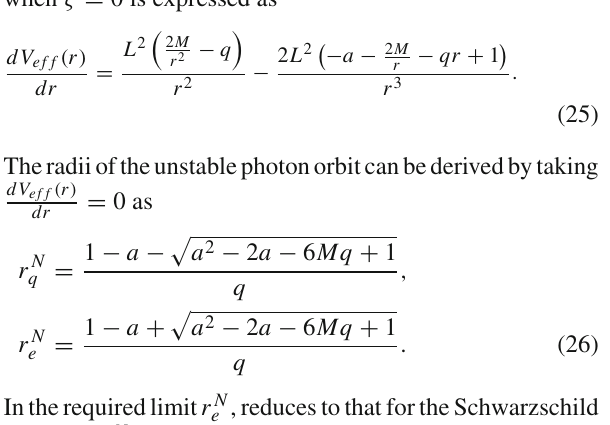
Fig. 5 Shows the behavior of V ef f ( r ) for the different possible values of a and q . The left panel of the first row represents q = 0 . 01 (blue), q = 0 . 02 (black), and q = 0 . 03 (red) with a = 0 . 3. The middle panel of the first row represents q = 0 . 01 (blue), q = 0 . 02 (black), and q = 0 . 03 (red) with a = 0 . 5. The right panel of the first row represents